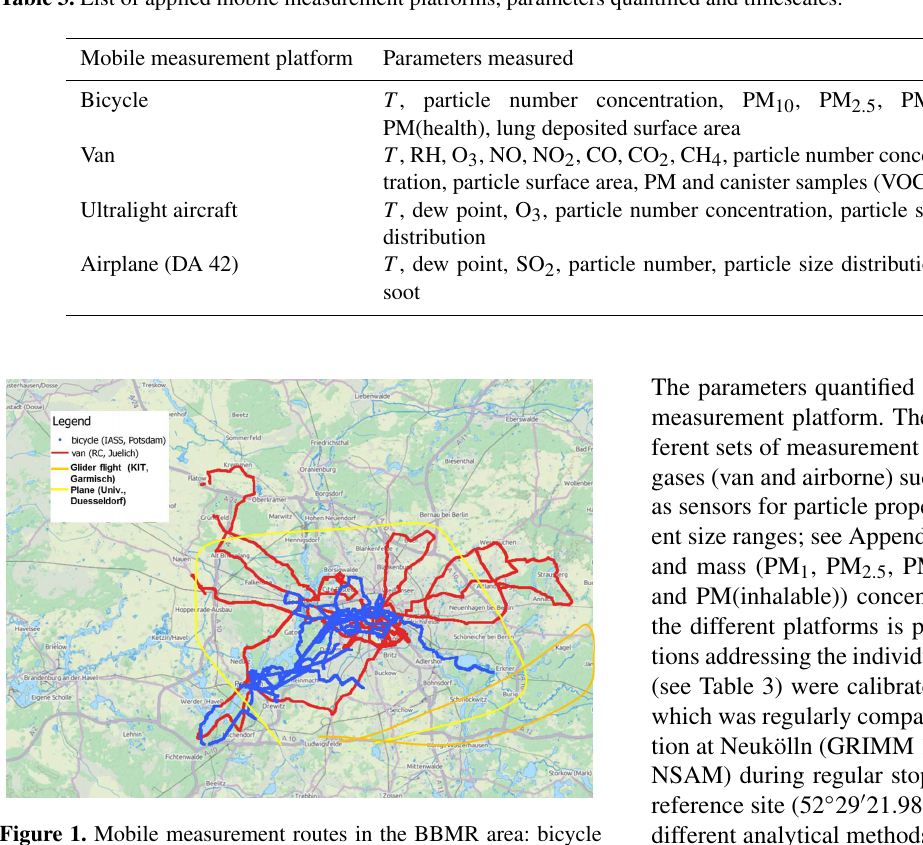
Figure 1. Mobile measurement routes in the BBMR area: bicycle routes in blue, van routes in red and airborne tracks in yellow (air plane) and orange (glider). Berlin is located in the center and Pots- dam at the southwestern concurrence of different bicycle and van